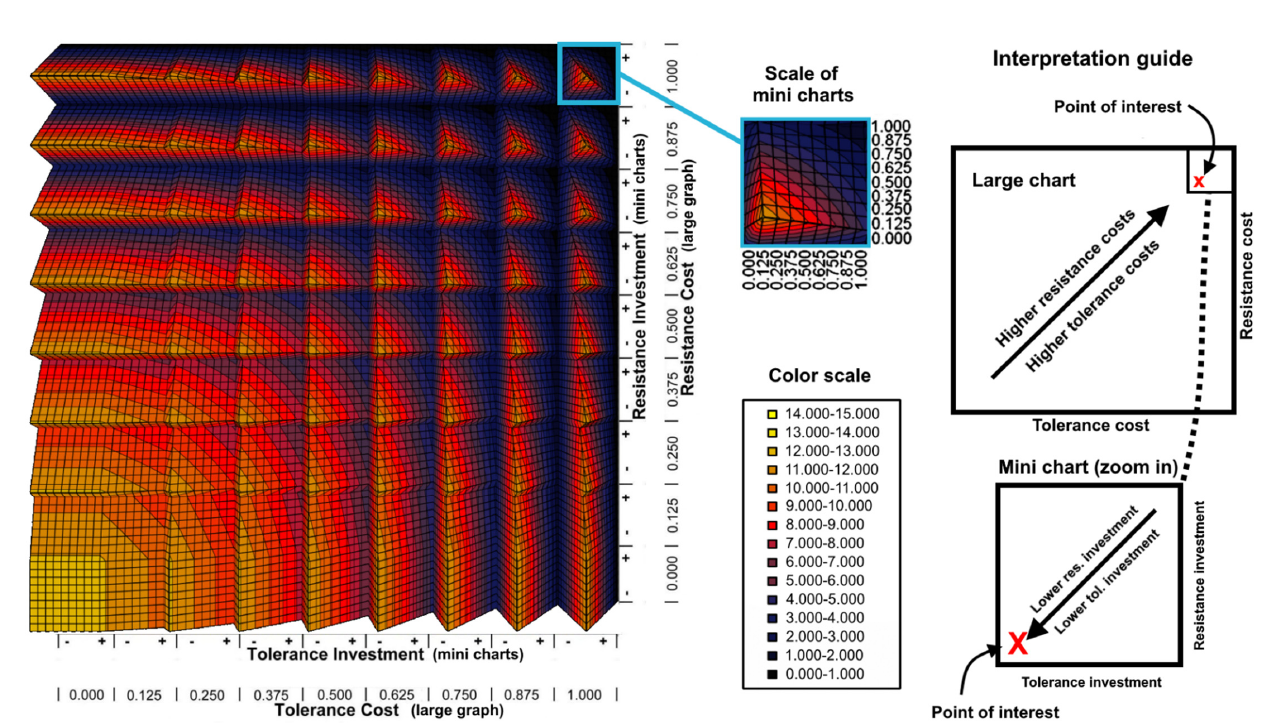
Figure 1. Fitness surface as function of resistance and tolerance. The charts show the fitness surface as a function of both costs and investments of resistance and tolerance. The large chart can be seen as the union of many mini charts that show a fitness surface as a function of resistance investment (vertical axis) and tolerance investment (horizontal axis) for a given combination of resistance cost (vertical axis, large scale) and tolerance cost (vertical axis, large scale). The tolerance benefit was set to 1- c t (e.g., 0.3 of tolerance cost also corresponds to 0.7 of tolerance benefit). This panel only repre- sents the multiplicative model with non-herbivory (see the remaining combinations of multiplica- tive/additive and herbivory/non-herbivory in Sup. Figure S4). Fitness was defined as the overall number of seeds a population could produce in the absence of herbivores, and the costs and benefits are defined as proportions of fitness. Because resistance benefits depended on complex interactions with herbivores, they were not incorporated here. To facilitate interpretation, the drawing on the right shows the general tendencies in the large and small charts, with the “point of interest” having high resistance and tolerance costs (=1.000 for both) but low tolerance and resistance investments (=0.000, both), which result in a fitness value of 11.000 − 12.000 in the actual graph. The two scenarios, resistance and non-resistance, led to different expectations for the plant’s mating system. In the resistance scenario, resistance costs promote the minimiza- tion of the number of resistance alleles carried out by plants, as one single allele suffices to confer protection under the gene-for-gene model. In selfers, however, the increased ho- mozygosis causes plants to carry more than one resistance allele, giving them additional resistance costs, which we call “ the resistance cost of selfing ”. Tolerance, in contrast, is not predicted to interact directly with the mating system. Despite these predictions, real pop- ulations can have a continuous supply of non-optimal genotypes by means of segregation and random mating, allowing the presence of mixed strategies. This, however, is better assessed by simulations. 2.1.2. Inbreeding Depression Some obvious predictions, e.g., the intensity of inbreeding depression being corre- lated with the selection coefficient of harmful alleles, will not be further discussed. A more useful task is the assessment of equilibrium points at which the systems would no longer change in terms of the number of harmful alleles and individual heterozygosity. The